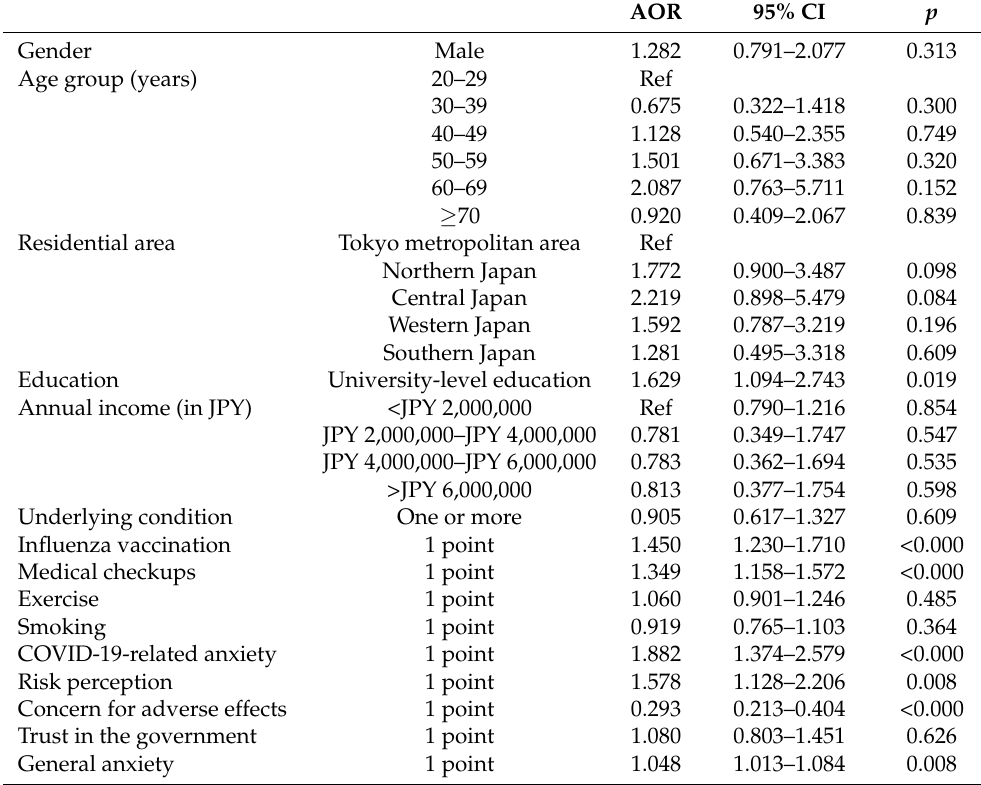
Table 6. Ordinal logistic regression for vaccination attitude in September